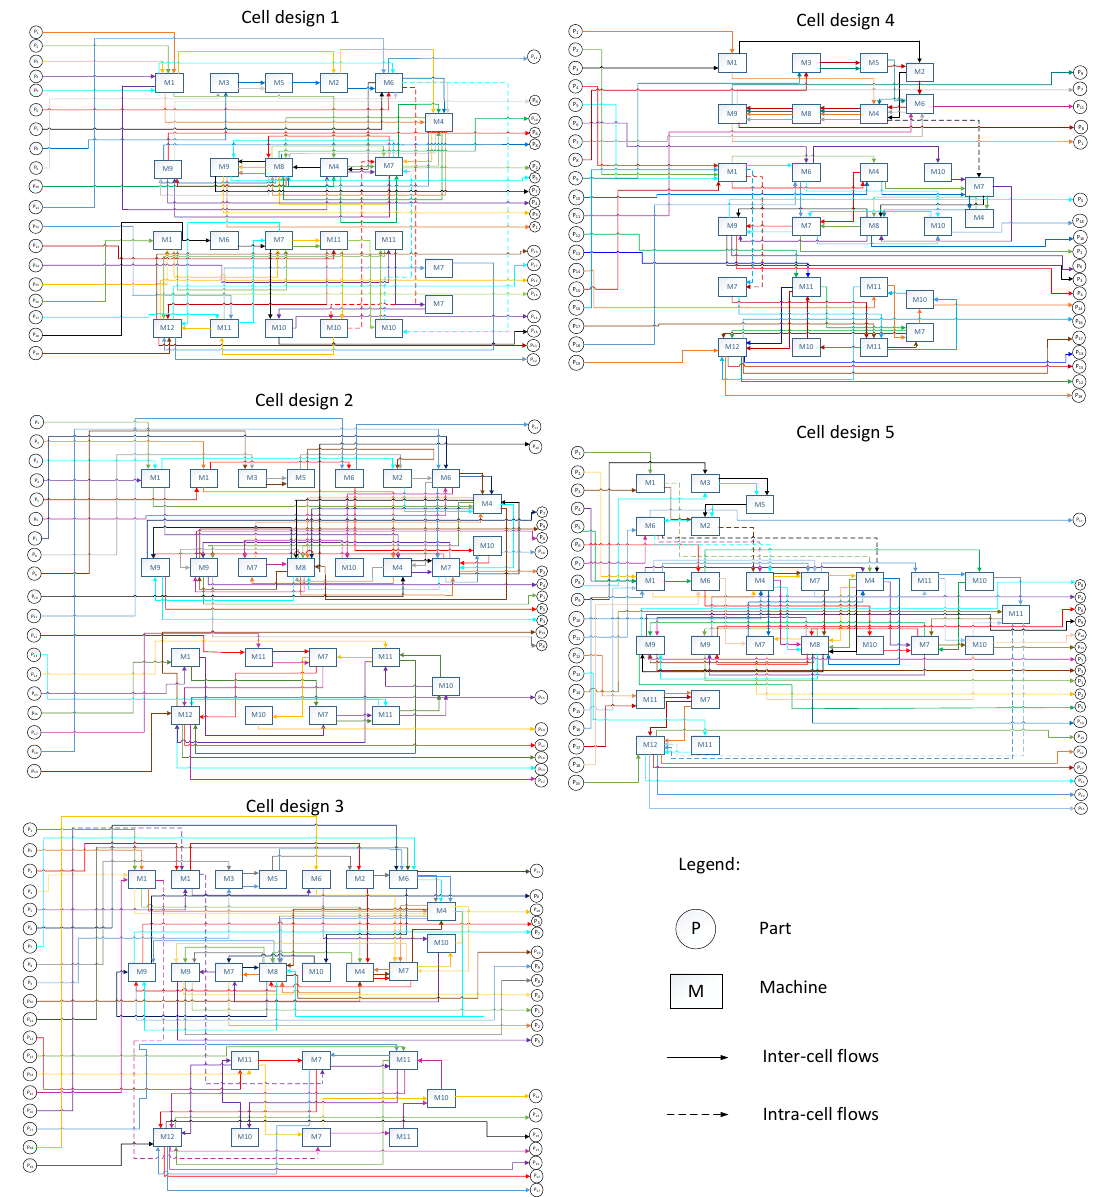
Figure 5. Cell design alternatives and their material flows.